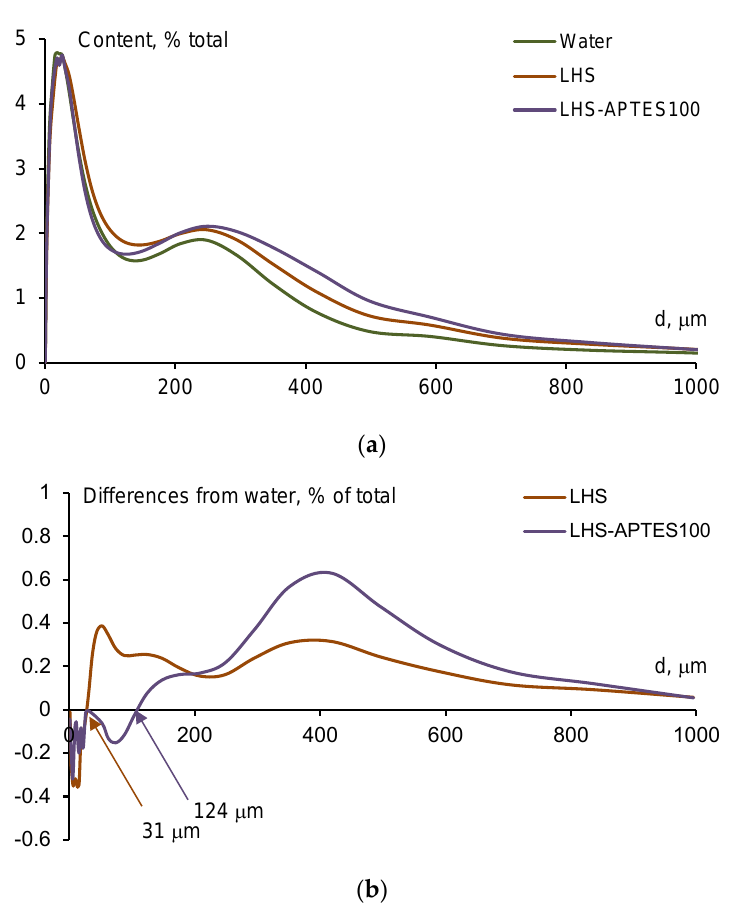
Figure 5. Particle size distribution curves for micro aggregates in the studied soils two months after five treatments with LHS and LHS-APTES100 under the field experiment conditions: ( a ) particle size distribution curve; ( b ) a relative content as compared to the control one. Table 3. The content and mean-weight diameter (MWD) of water-stable aggregates (WSA) and water-stable micro aggregates (WSMA) in the treated Urbic